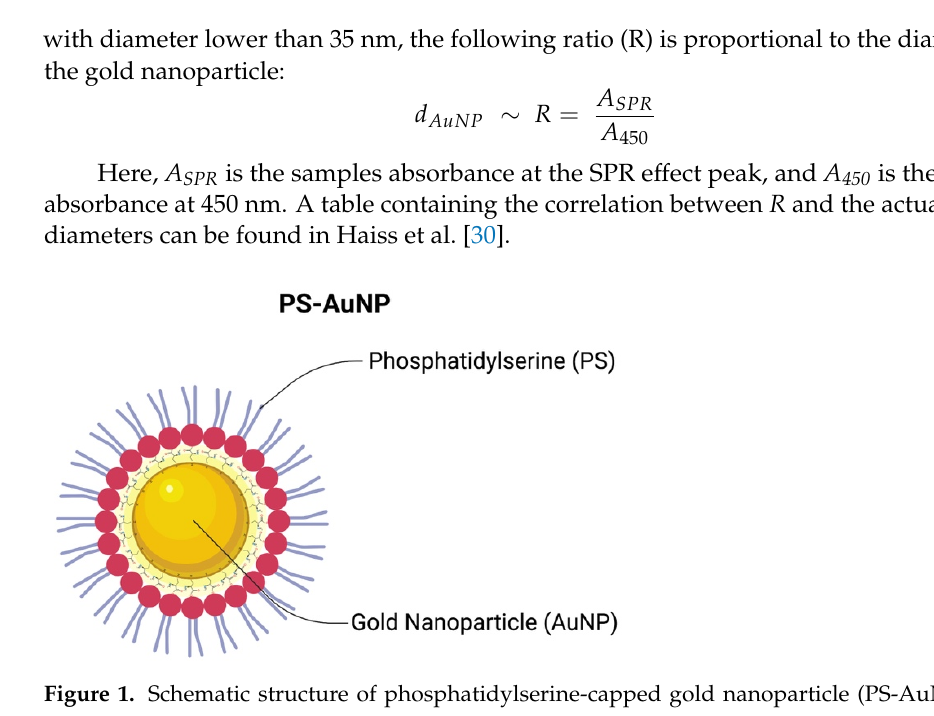
Figure 1. Schematic structure of phosphatidylserine-capped gold nanoparticle (PS-AuNP) after EDC/NHS coupling.